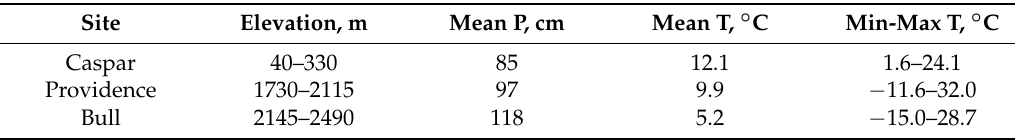
Table 1. Study site characteristics of elevation, mean annual precipitation (Mean P), mean annual temperature (Mean T), and annual temperature range (Min-Max